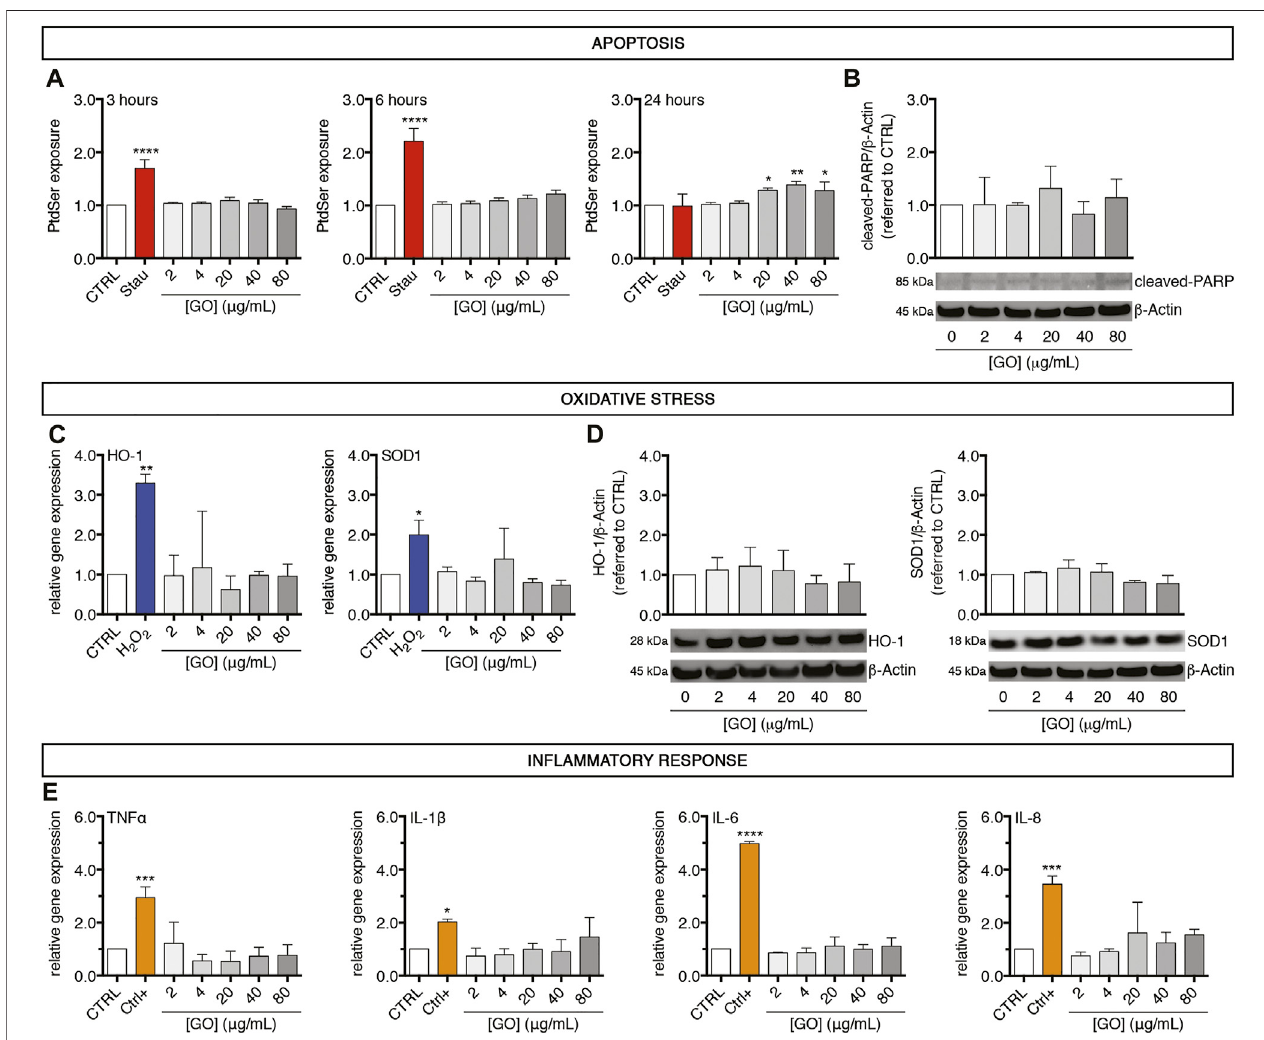
FIGURE 3 | A 24-h exposure of GO induces early weak apoptosis but not oxidative stress nor in fl ammation in upcyte ® hepatocytes treated at sub-lethal concentrations. (A) Temporal exposure of PtdSer in GO-treated cells evaluated at different time points (3, 6, and 24 h) by apoptosis assay. “ Stau ” refers to the positive control, represented by cells treated with 0.5 μ M Staurosporine for 24 h. Results are expressed as an n-fold increase over the control condition (indicated as CTRL) for each incubation time. Results represent means ± SD of three independent experiments. The symbols “ * ” , “ ** ” and “ **** ” refer to p ≤ 0.0429, p = 0.0043 and p < 0.0001, respectively, calculated versus CTRL (ordinary one-way ANOVA). (B) Protein levels of cleaved-PARP in GO-treated cells in comparison to CTRL, assessed by western blot. Densitometric analysis of three blots derived from independent experiments (means ± SD; upper panel) and a representative blot (lower panels) are reported. β -Actin was used as the internal control to normalize densitometric values of all culture conditions. (C) Relative gene expression of cellular antioxidants HO-1 (left) and SOD1 (right) in GO-treated cells versus CTRL, analysed by qPCR. “ H 2 O 2 ” refers to the positive control, represented by cells treated with 400 μ M H 2 O 2 overnight. Results are expressed as means ± SD values of three independent experiments. The symbols ‘ * ’ and ‘ ** ’ refer to p = 0.0269 and p = 0.0094, respectively, calculated versus CTRL (ordinary one-way ANOVA). (D) Protein levels of HO-1 (left) and SOD1 (right) in GO-treated cells compared to CTRL, assessed by western blot. For each marker, densitometric analysis of three blots derived from independent experiments (means ± SD; upper panel) and a representative blot (lower panels) are reported. β -Actin wasused asthe internal controltonormalize densitometric values ofallculture conditions. (E) Relative gene expression offour in fl ammationmediators (TNF α , IL-1 β , IL-6, and IL-8) in GO-treated cells versus CTRL, analysed by qPCR. “ Ctrl+ ” refers to the positive control (see technical details in Materials and Methods). Results are expressed as means ± SD values of three independent experiments. The symbols “ * ” , “ *** ” and “ **** ” refer to p = 0.0482, p ≤ 0.0008 and p < 0.0001 respectively, calculated versus CTRL (ordinary one-way